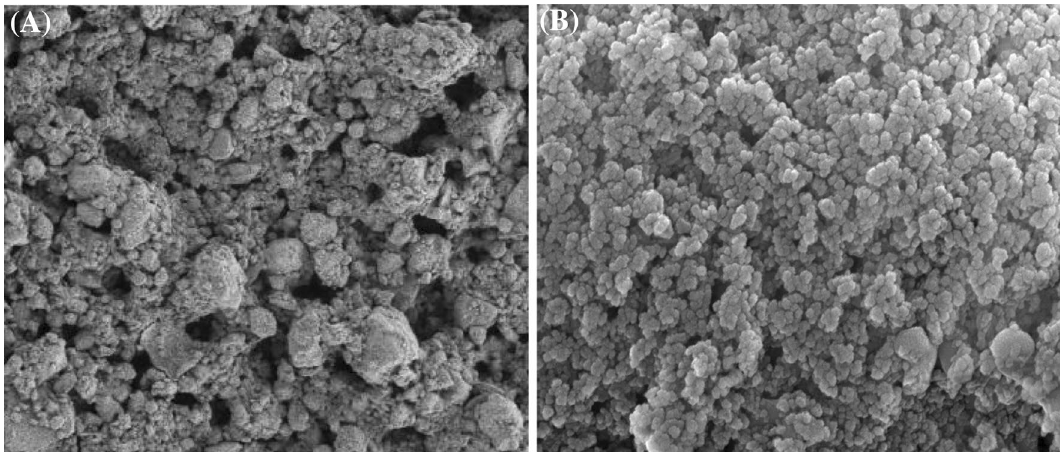
Figure 1. SEM images of (A) TiO 2 , (B) Al 2 O 3 nanoparticles.